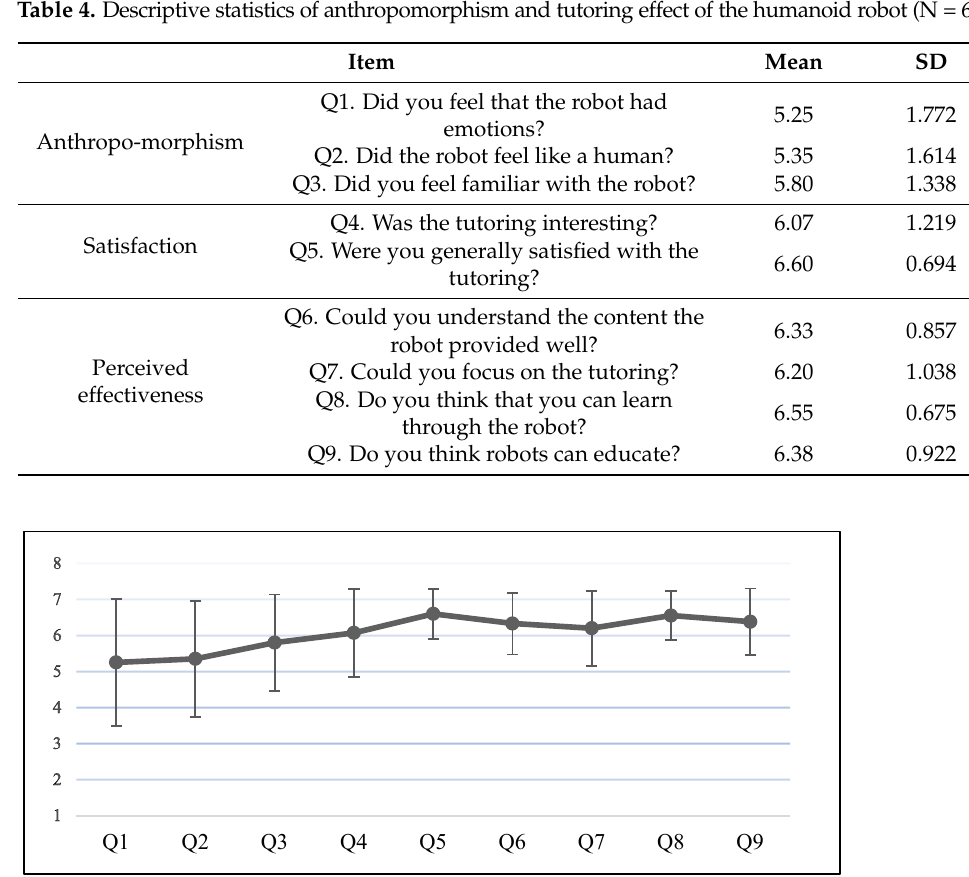
Figure 6. Descriptive statics of anthropomorphism and tutoring effect of the humanoid robot (N =